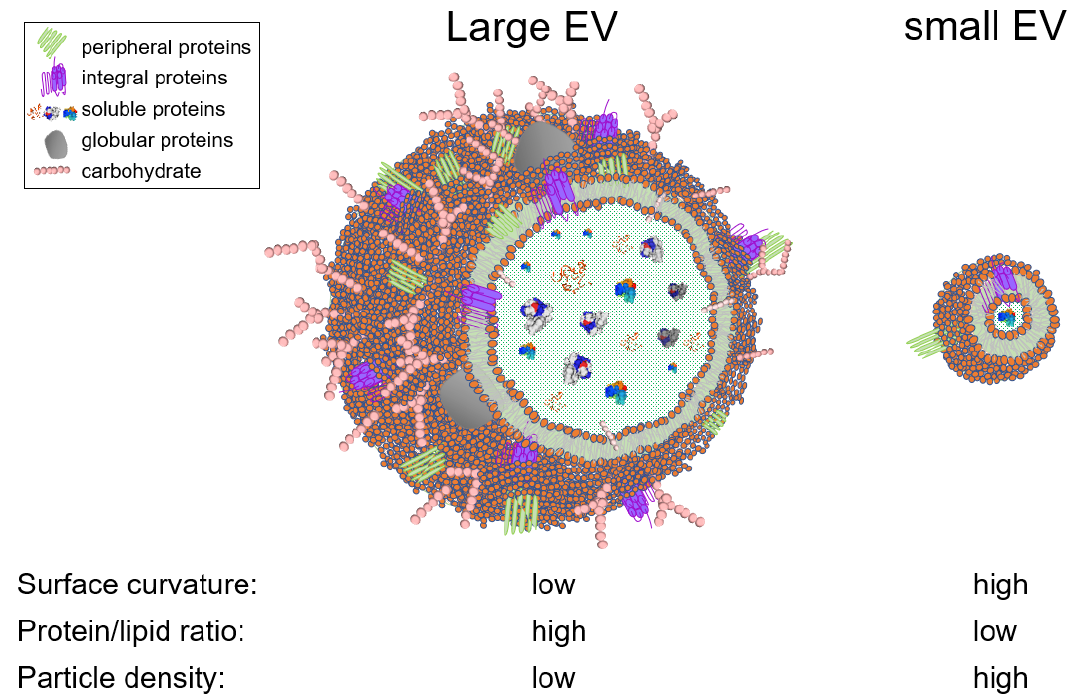
Figure 1. Schematic depicting the effects of the particle size on the composition and physiochemical properties of EVs. EVs contain other biomolecules that are not represented here, such as nucleic acids, small molecules.